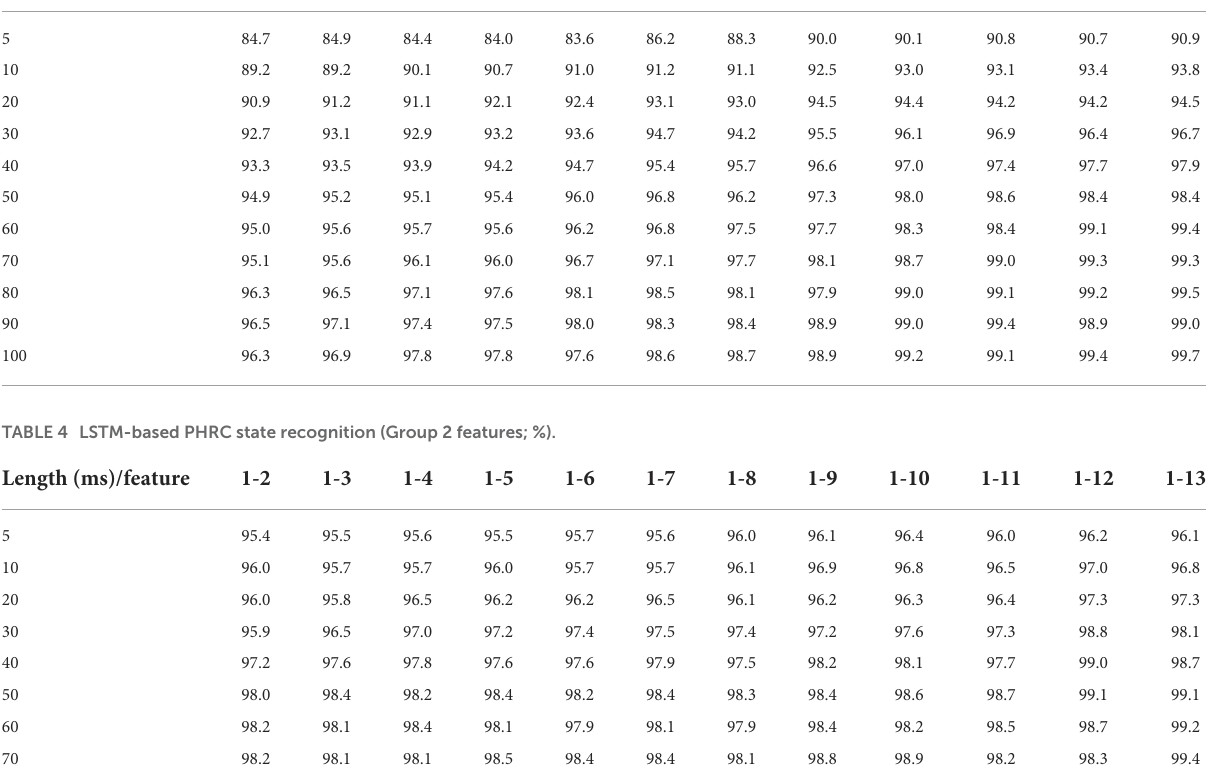
TABLE 3 Long short-term memory- (LSTM-) based physical human–robot collaboration (PHRC) state recognition (Group 1 features; %). Length (ms)/feature